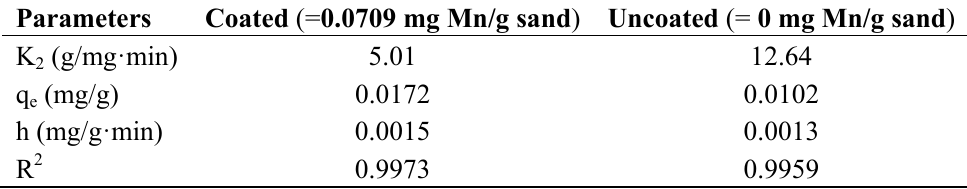
Table 4. Kinetic parameters obtained using pseudo-second-order kinetic model for speed = 150 rpm, T = 25.6